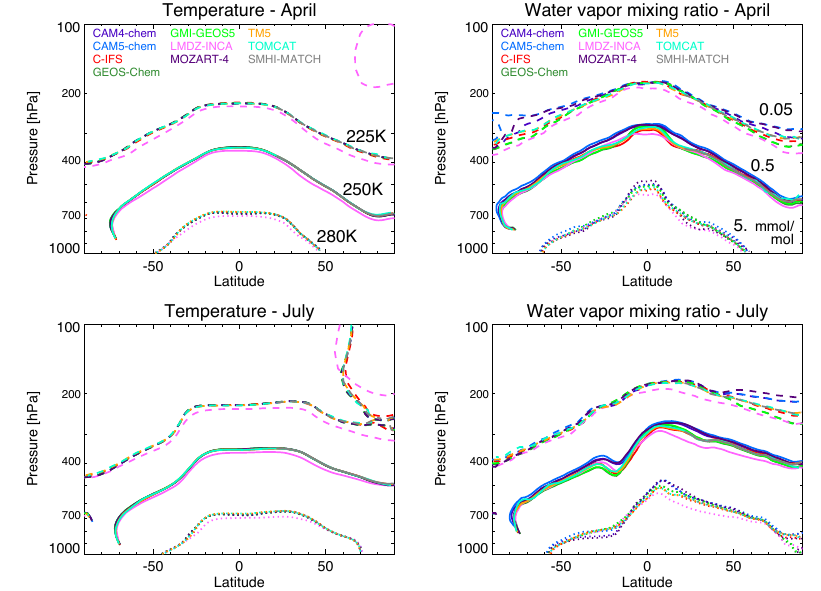
Figure 2. Zonal averages of temperature and water vapor from each of the models, for April and July.